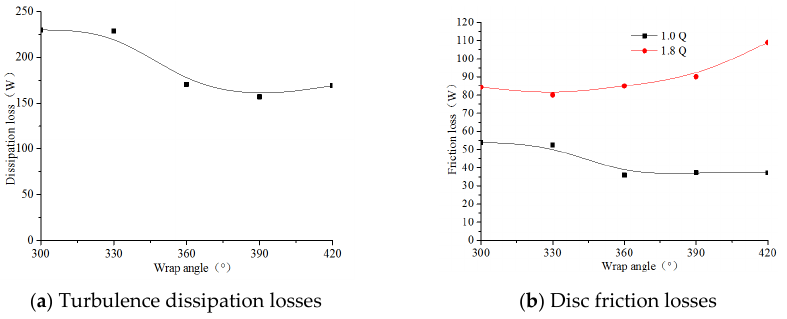
Figure 9. Energy loess of single blade centrifugal pump with different wrap angles.